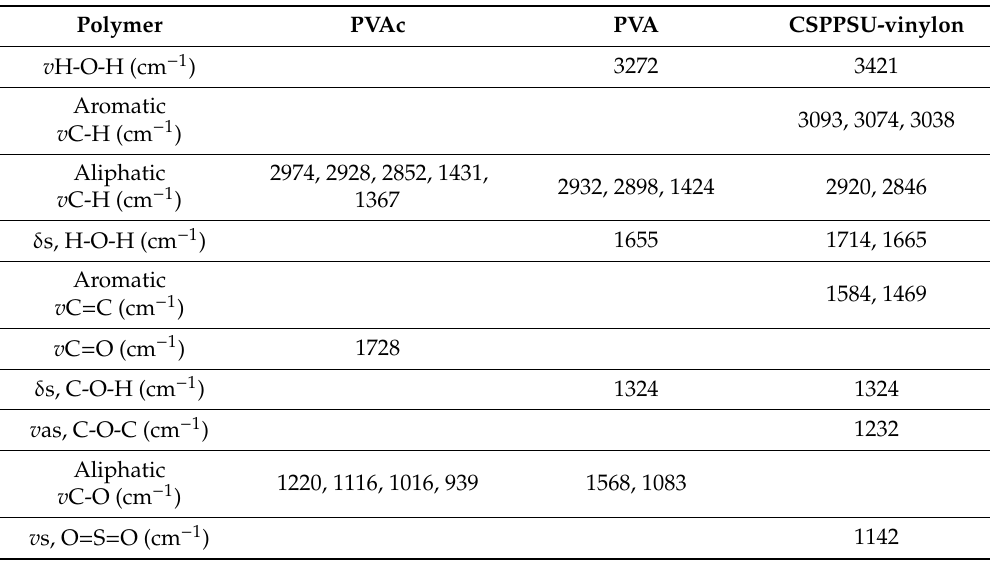
Figure 2. Fourier transform infrared (FTIR) properties of ( a ) polyvinyl acetate (PVAc), ( b ) syn. polyvinyl alcohol (PVA), ( c ) CSPPSU-5vinylon, ( d ) CSPPSU-10vinylon, and ( e ) CSPPSU-20vinylon membranes with different amounts of PVA. Table 2. Summary of assignments of the FTIR spectra of PVAc, syn. PVA, and CSPPSU-vinylon membranes.